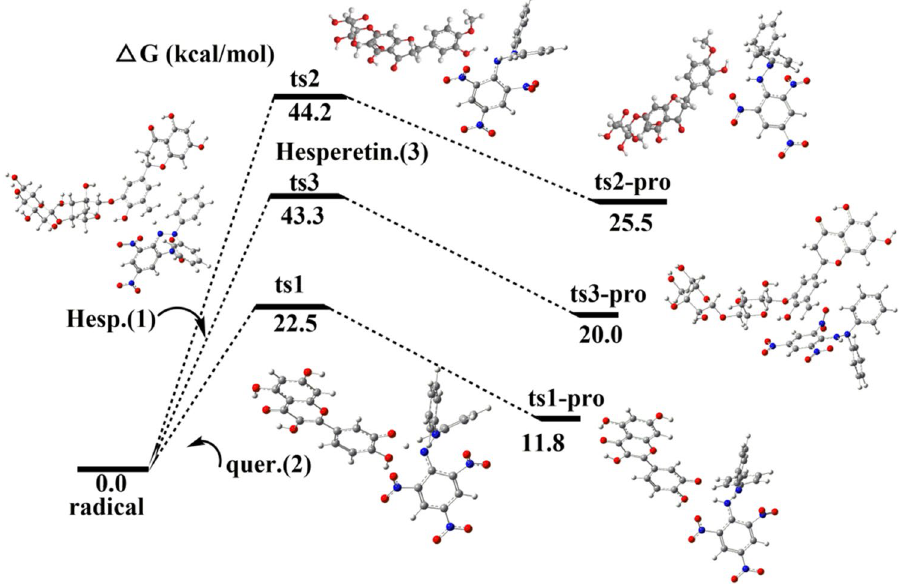
Figure 11. Comparison of dehydrogenation barriers for three flavonoid compounds with 3 ′ ortho substituents of the ring